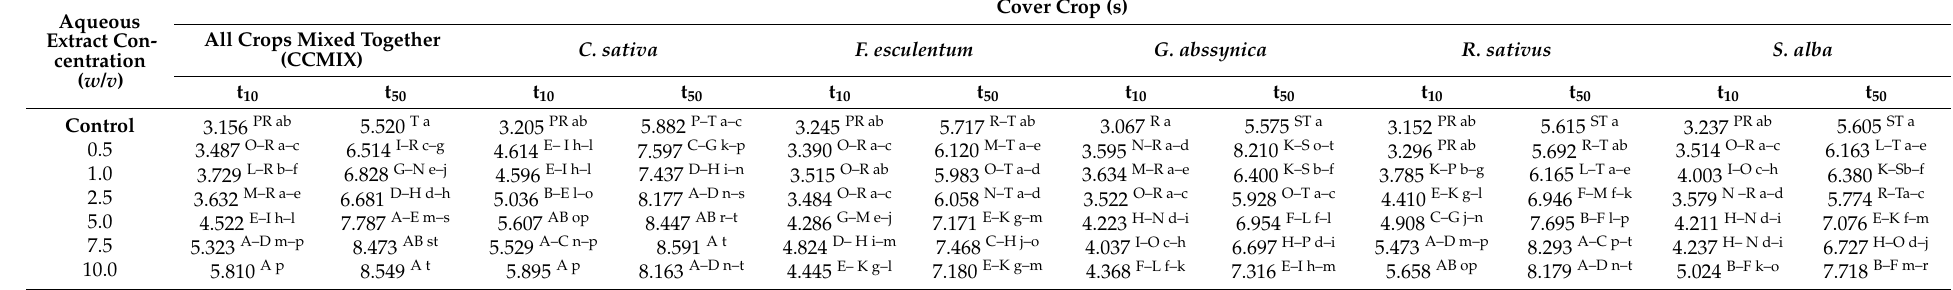
Table 3. The effect of aqueous extracts of CCs on the number of days needed for 10% (t 10 ) or 50% (t 50 ) of A. artemisiifolia seeds to